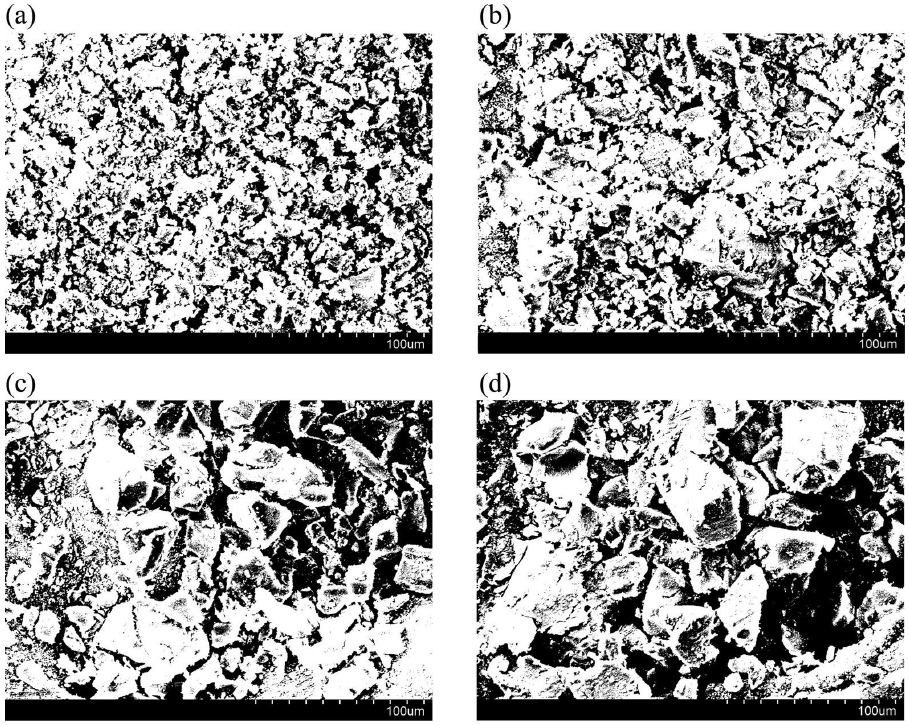
Figure 32. Thresholded SEM images of superhydrophobic aerogel coatings with different particle-size ranges. ( a ) 0–43 µ m; ( b ) 43–104 µ m; ( c ) 104–150 µ m; ( d ) 150–210 µ m. From Samaha et al.